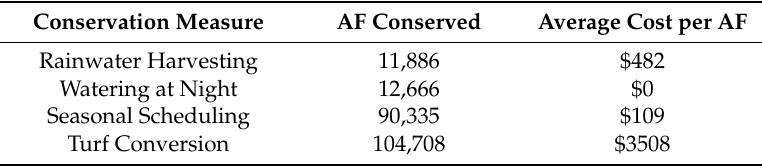
Table 3. Outdoor Residential